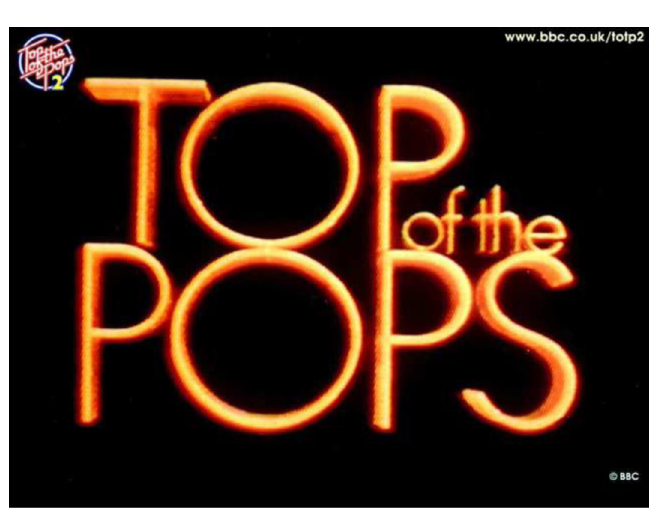
Figure 2. Top of the Pops Logo 1970s. Click here to see the